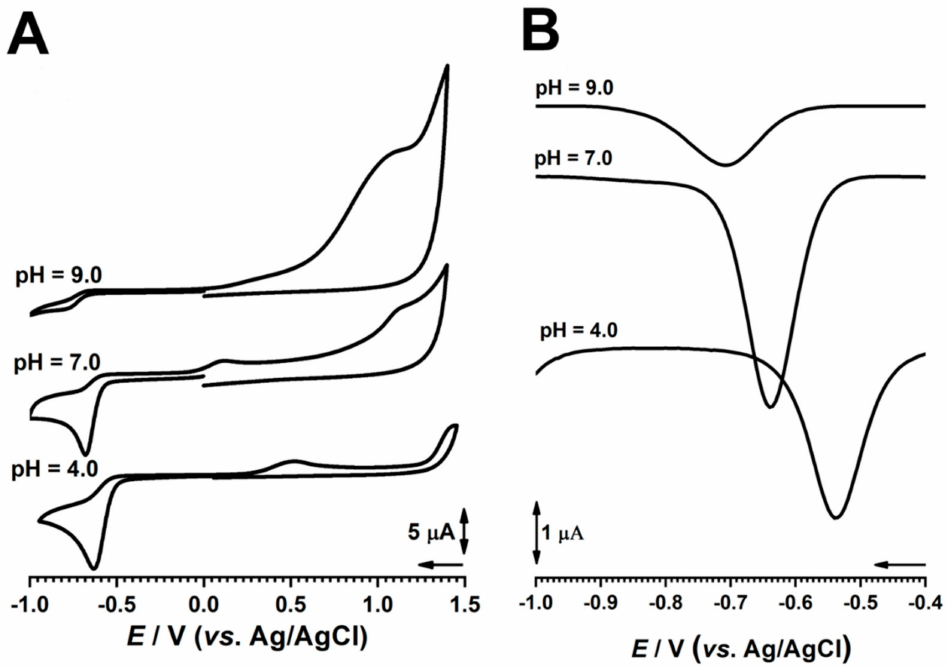
Figure 3. ( A ) CV at v = 100 mV s − 1 and ( B ) DPV in 500 µ M AZA in electrolytes with different pH